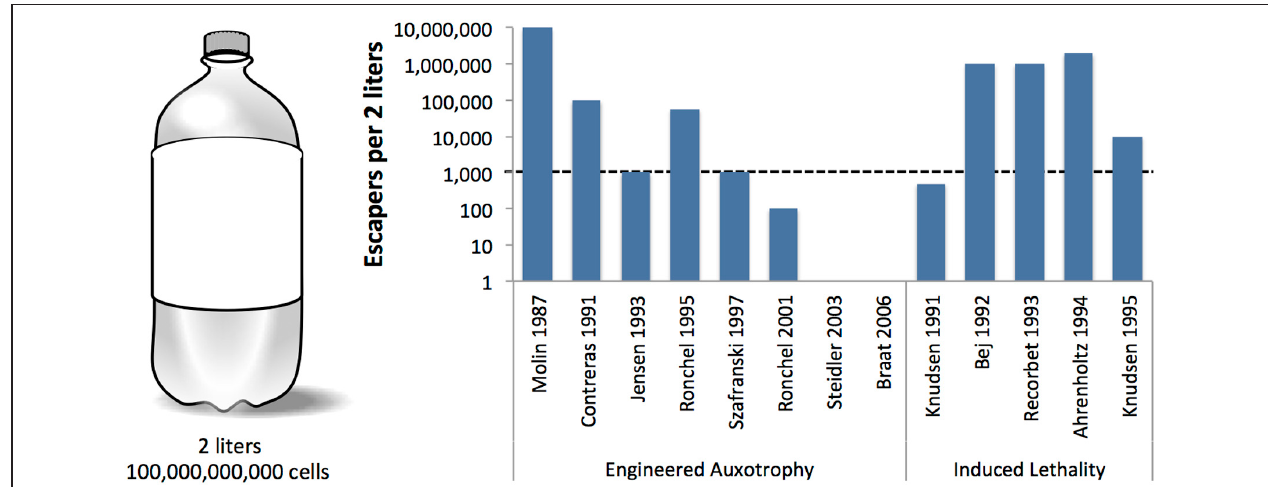
FIGURE 2 | Reported frequencies of engineered bacteria that escape various genetic safeguard systems. A 2-liter volume is represented here as a standard soft drink container (left). Lowest reported frequencies (shown on the y-axis, log scale) were multiplied by the estimated number of cells